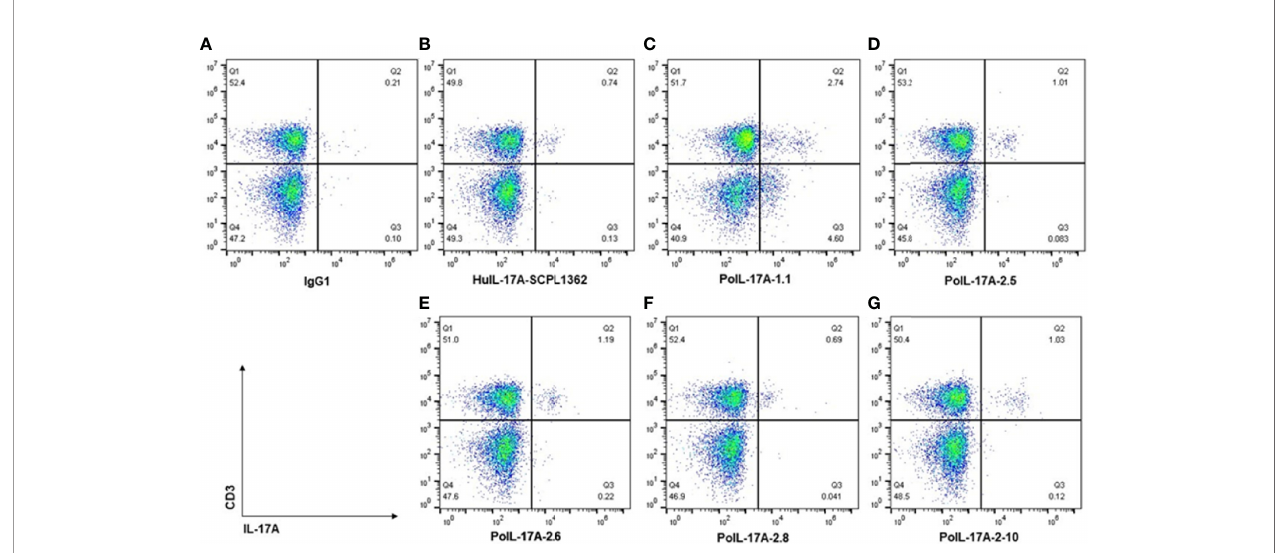
FIGURE 4 | Intracellular staining of pig cells with AF647 labeled a PoIL-17A mAbs. Frozen PBMC were cultured overnight before stimulation with BD Leukocytes activation cocktail [containing phorbol myristate acetate (PMA)/ionomycin), and a protein transport inhibitor (Brefeldin A)]. Cells were stained with BD fi xable viability stain and Fc receptors were blocked with rabbit serum before surface staining with a CD3 mAb. Cells were then fi xed and permeabilized before intracellular staining with each AF647 labeled a PoIL17A mAb. Data were collected using fl ow cytometry, gating on live lymphocytes and on live CD3+ T cells, and analyzed using FlowJo Software. Shown are staining data for controls (A, B) and 5 new anti-PoIL-17A mAbs (C – G)